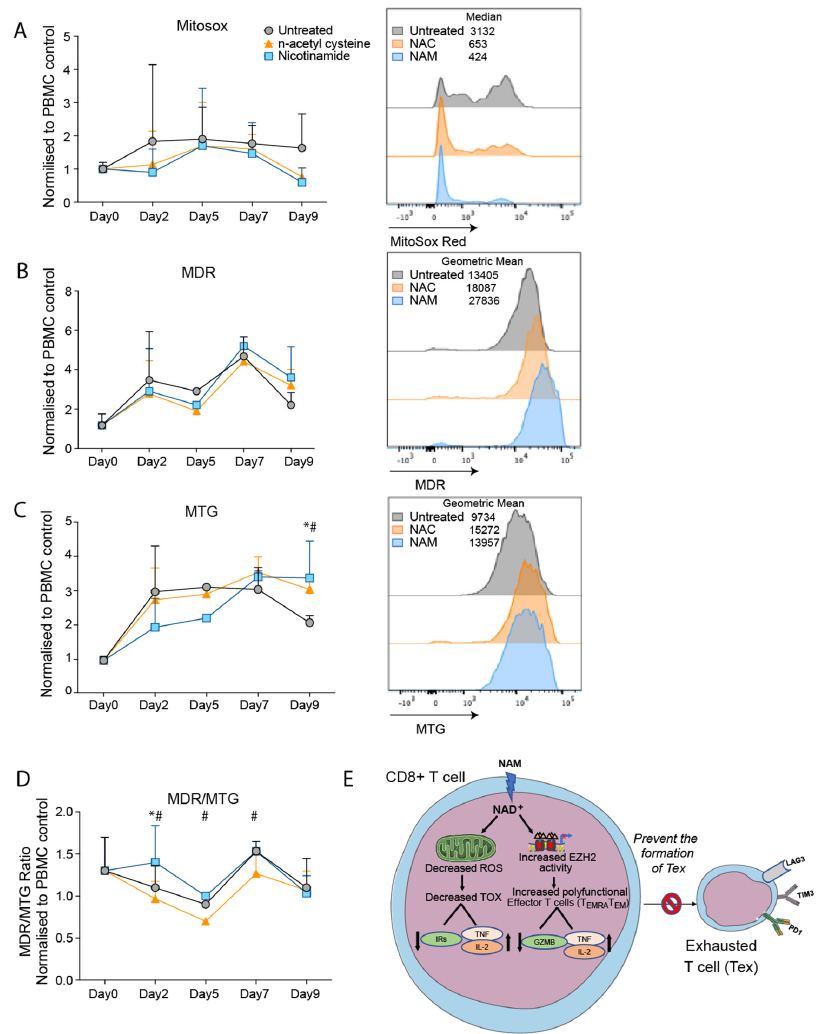
Figure 6. Evaluation of mitochondrial function in the presence of NAM and EZH2i and their combination . ( A ) median expression of MitoSOX based flow cytometry detection of mitochondrial reactive oxygen species (ROS) production, showing mean and standard deviation from three independent experiments. ( B ) Mitotracker red (MDR) and ( C ) green (MTG) assessment of mitochondrial membrane potential and mitochondrial mass, ( D ) with ratio of MDR to MTG also shown for three independent experiments. Statistical significance determined when treated conditions compared to untreated for each donor as indicated by * for nicotinamide and # for n-acetyl cysteine, as determined using the Holm-Sidak method ( α = 0.05). ( A – C ) graphs are shown as relative to PBMC controls run concur- rently for each time point, with histogram showing representative expression comparing treatment groups. ( E ) Schematic view of the effect of NAM on exhausted t cells through mitochondrial function. NAM, nicotinamide; NAC, n-acetyl